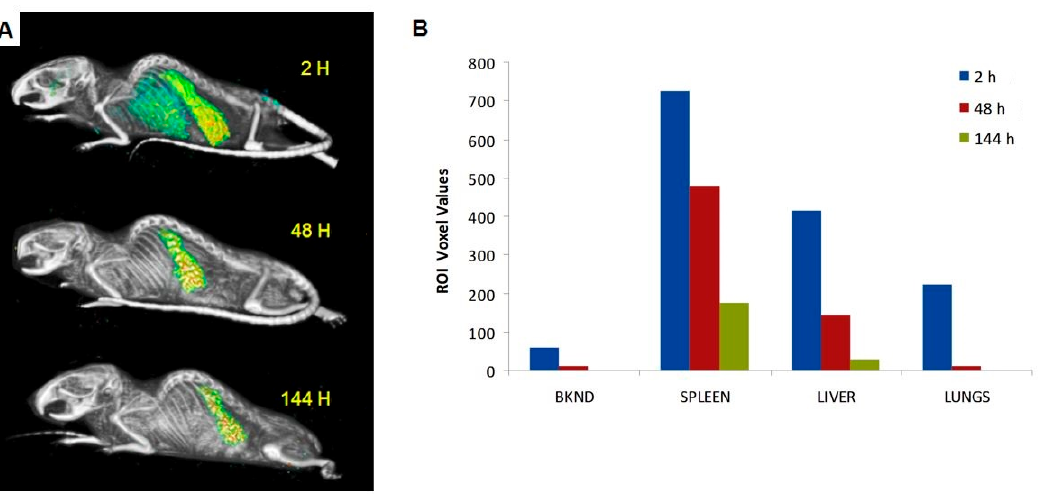
Figure 2. In vivo SPECT images ( A ) of normal nude mouse injected with [ 111 In]-Liposome through the tail vein and imaged at 2, 48, and 144 h post-injection. Initial high uptake in the RES tissues was significantly reduced at later time points. Relative radioactive signal intensity of [ 111 In]-Liposome in the spleen, liver, and lungs, compared to a background region on the image, is shown. All regions were determined by regions of interest (ROI) analysis of SPECT images ( B ).